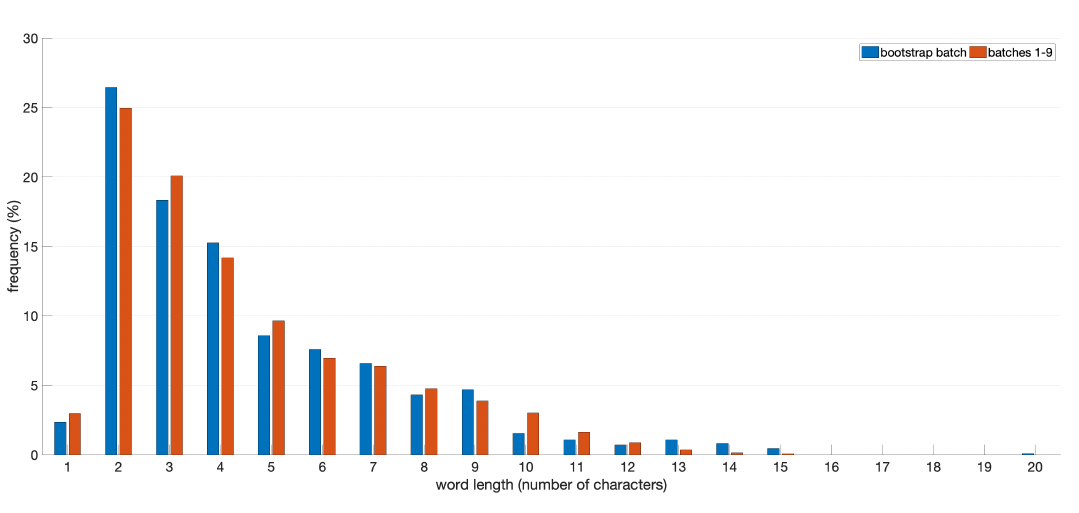
Figure 5. Word length distribution. The distribution of words in the bootstrap batch is depicted in blue. The distribution of words included in the union of batches from 1 to 9 is depicted in